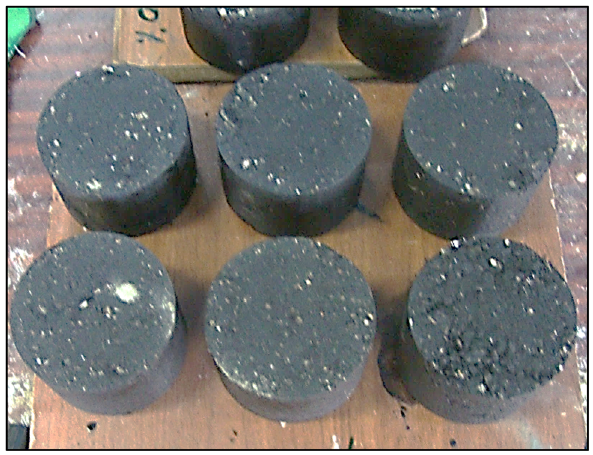
Figure 5: Photo represents the generated asphalt samples.